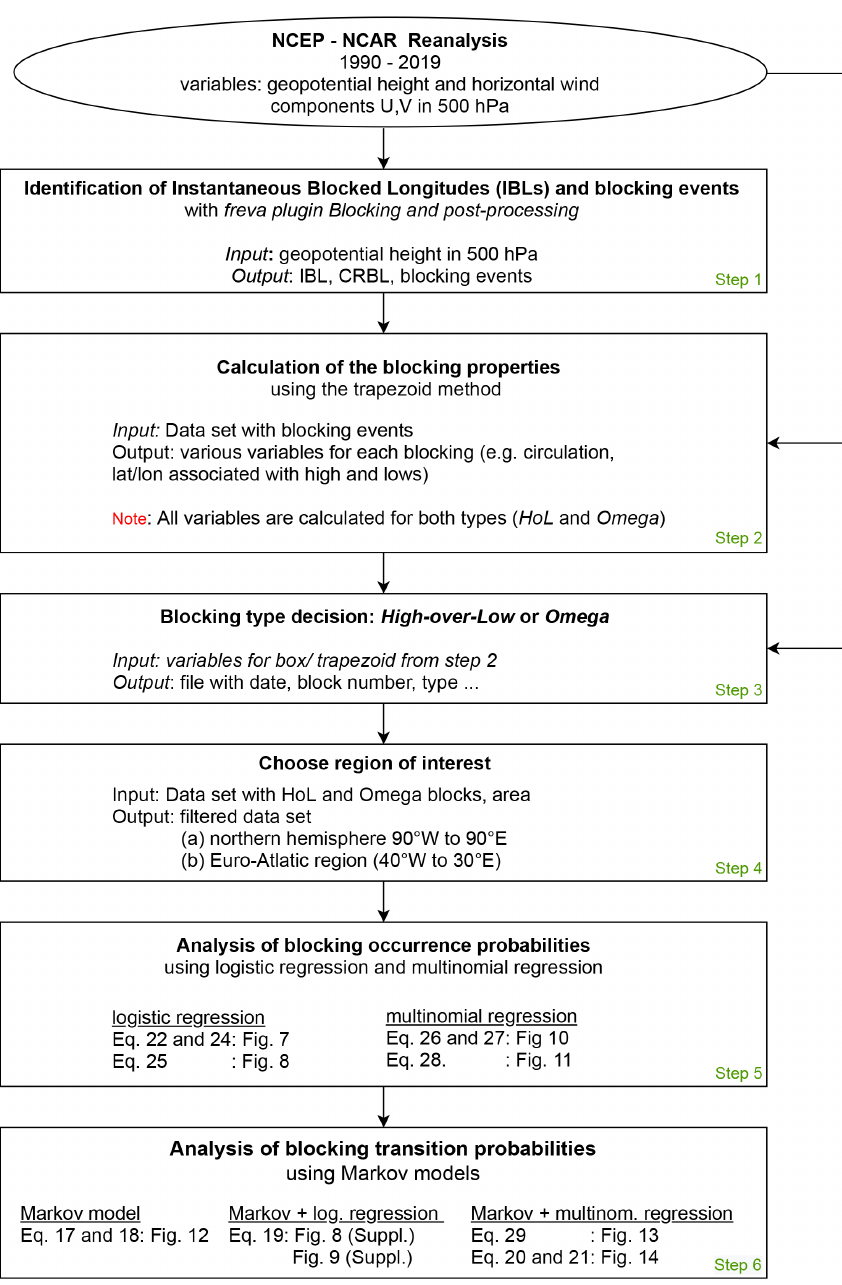
The highs and lows are detected by an analysis of the kinematics of the flow. Therefore, we use the dimension- less kinematic vorticity number W k = (cid:107) (cid:127) (cid:107) / (cid:107) S (cid:107) (Truesdell, 1953, 1954), which compares the local rotation rate (cid:107) (cid:127) (cid:107) and strain rate (cid:107) S (cid:107) at each grid point. Here, (cid:127) = [∇ v − ( ∇ v ) T ] / 2 and S = [∇ v + ( ∇ v ) T ] / 2 denote the anti-symmetric and sym- metric components of the velocity gradient tensor ∇ v that de-